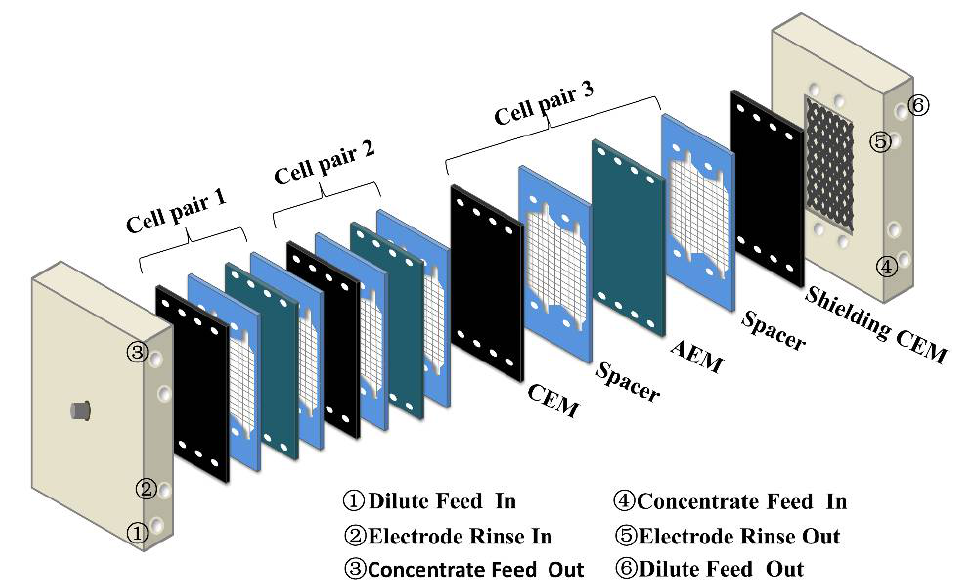
Figure 1. The RED stack used in the experiment.